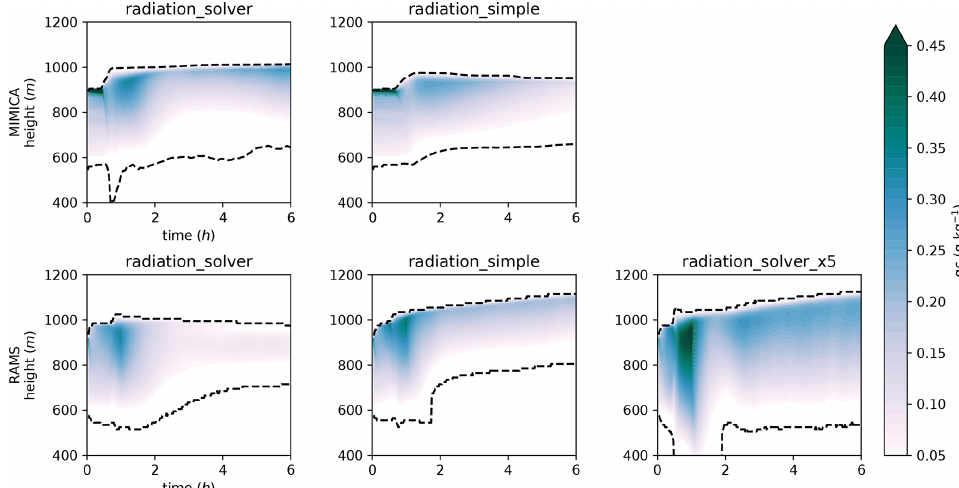
Figure A1. Cloud droplet mixing ratio (qc) shown for a simulation AC3_AK20 initialized with different radiative schemes in MIMICA and RAMS. The title radiation_solver is used for the simulations in which the models are initialized with their default radiation solvers (Fu and Liou, 1993, in MIMICA and Harrington, 1997, in RAMS). The title radiation_simple is used for the simulations where the radiative fluxes are calculated as functions of LWP only (Stevens et al., 2005, in MIMICA and Chen and Cotton, 1983, in RAMS). The radiation_solver_x5 simulated by RAMS shows the qc obtained with the default radiation solver but with a 5 × higher cooling rate enforced at cloud top. The simulations are run for 6h. Black dashed lines represent the cloud top and cloud base